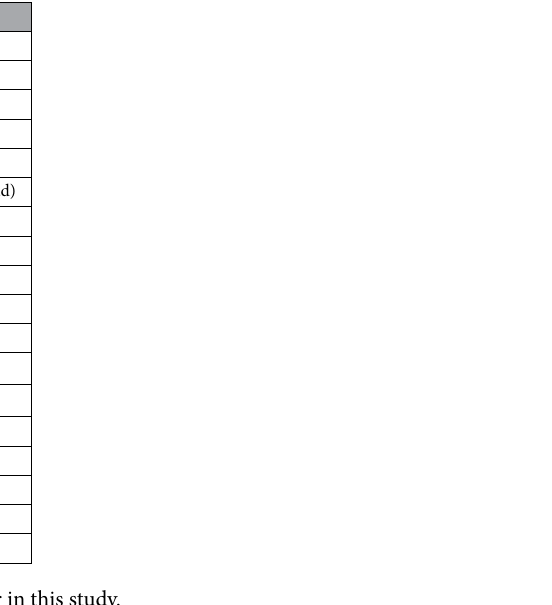
Table 1. Design of a baseline origami reservoir in this